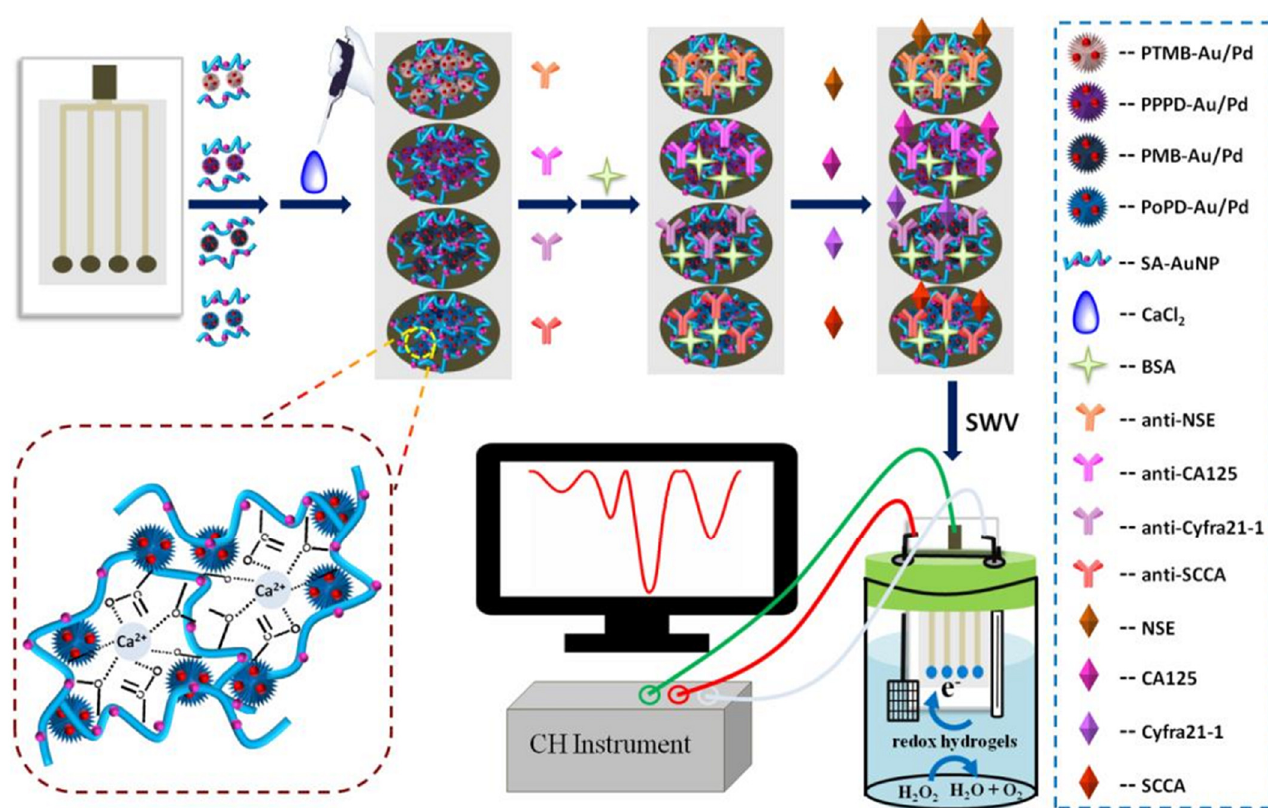
Figure 9. Schematic illustration of the offered label-free amperometric immunosensor by using the modified SPCE (adapted and reprinted with permission from [131]).